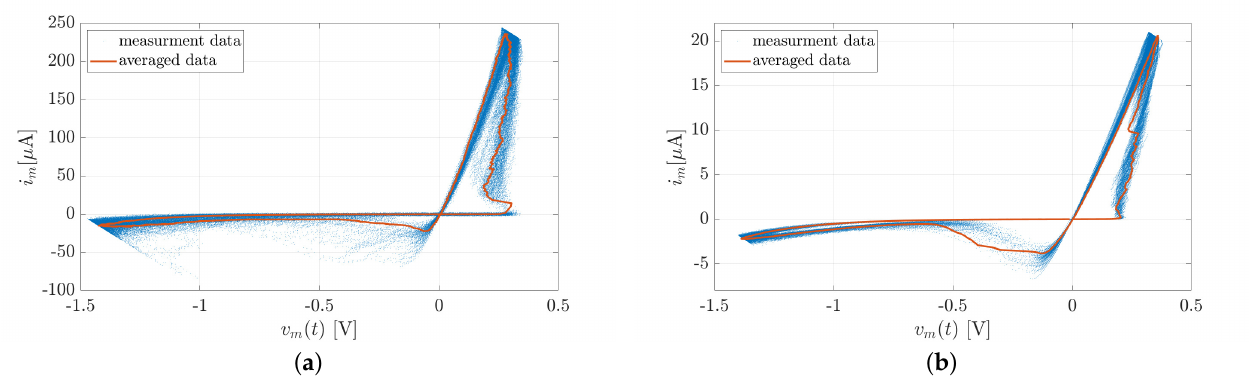
Figure 2. i − v plot of the measurement and the reference averaged data of the memristors with two kind of dopants. (sine wave, V s = 1.5V and f = 20Hz). ( a ) Tungsten dopant; ( b ) Carbon